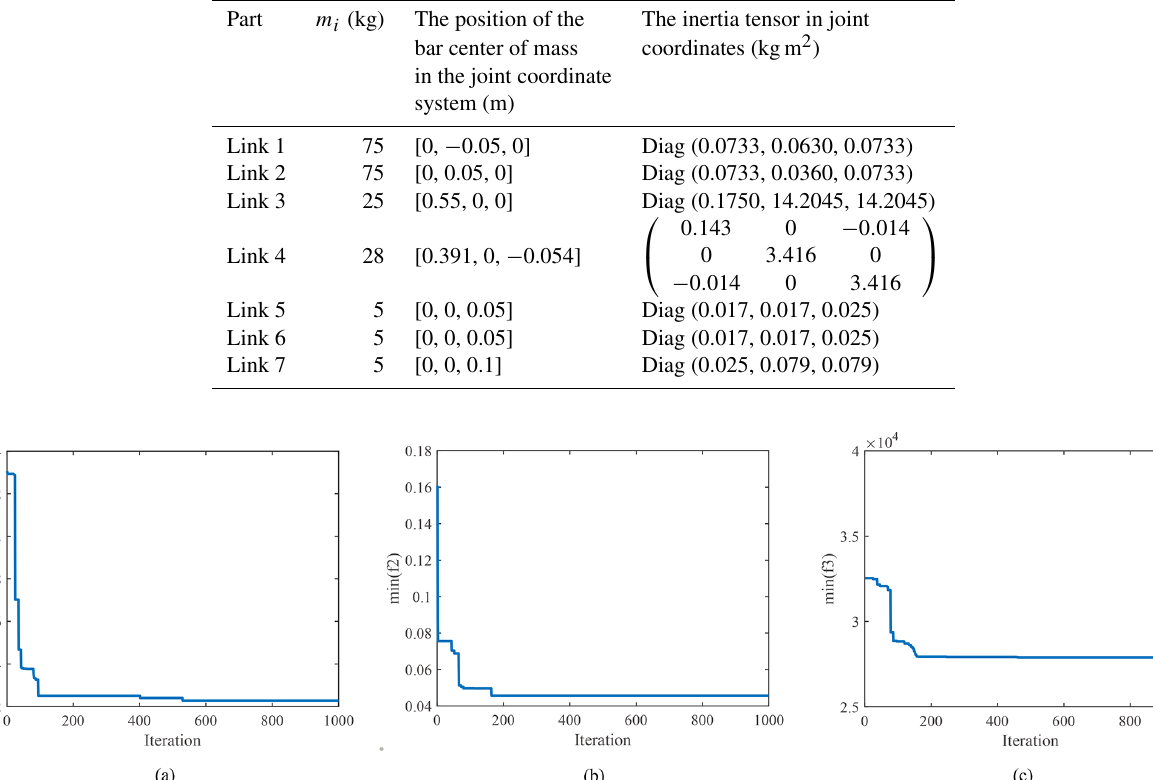
Table 1. Mass parameters a 7-DOF redundant manipulator.